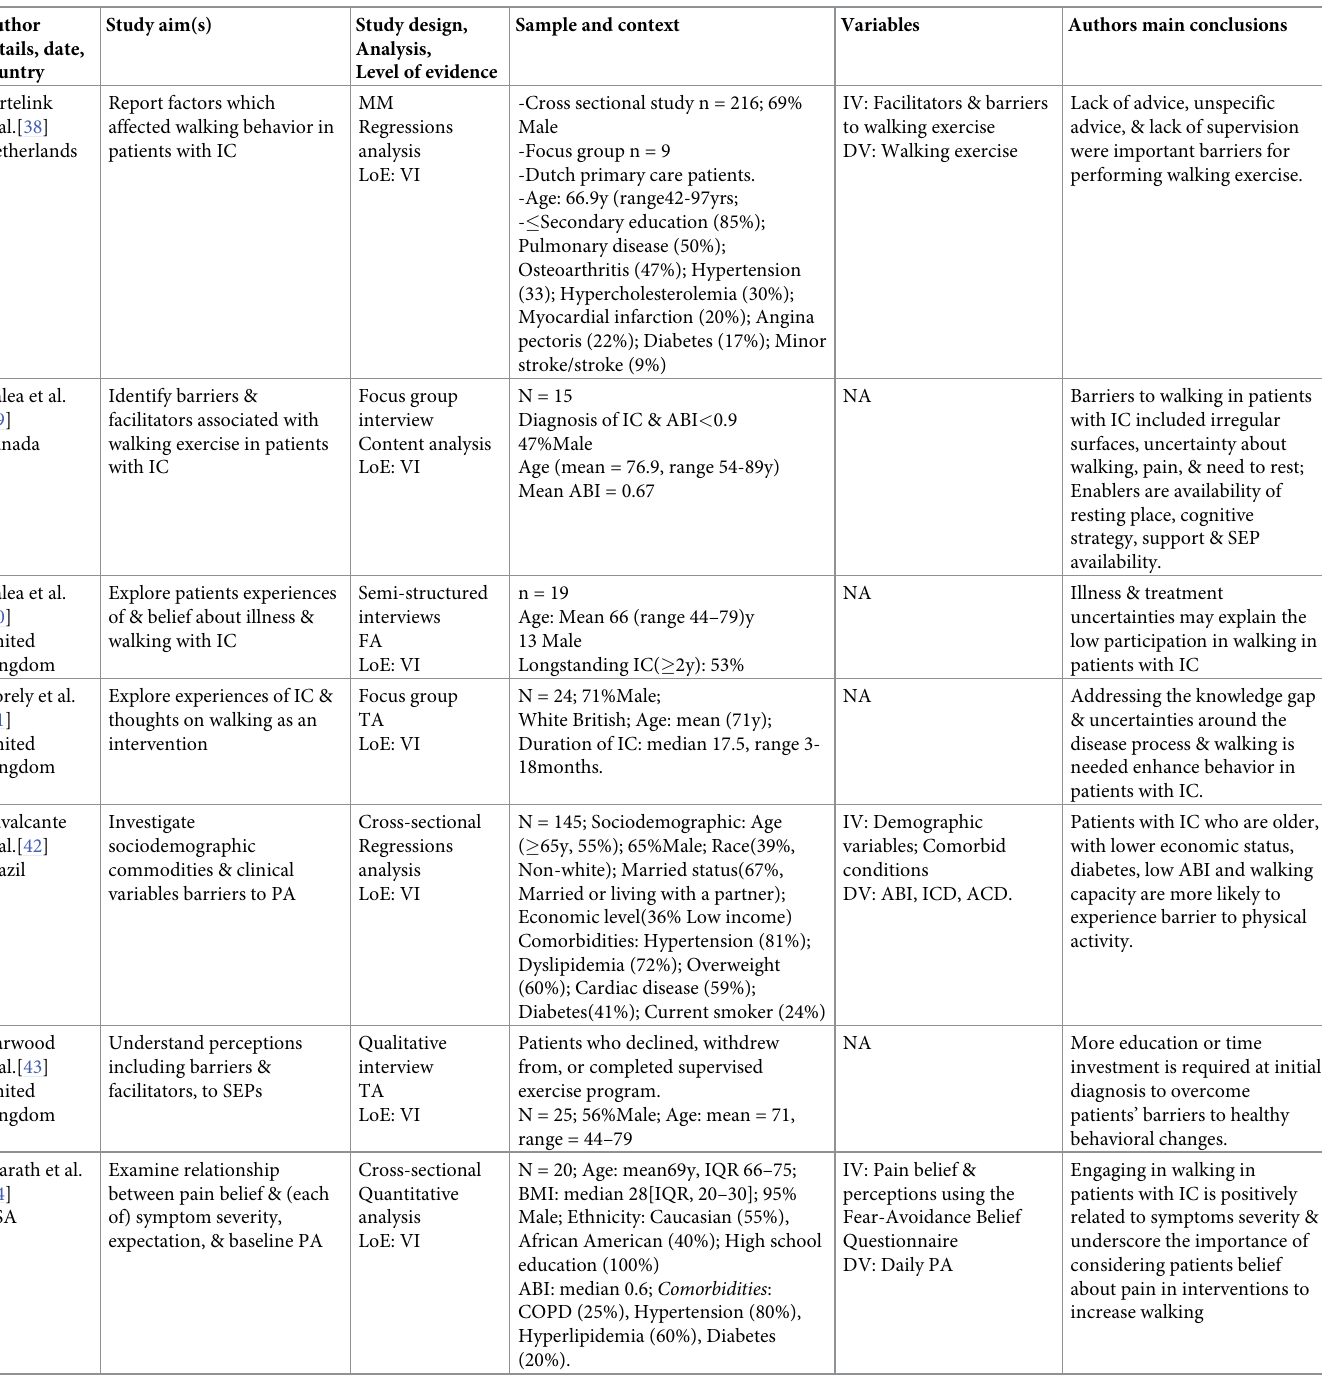
Table 1. Table of data extraction and characteristics of included